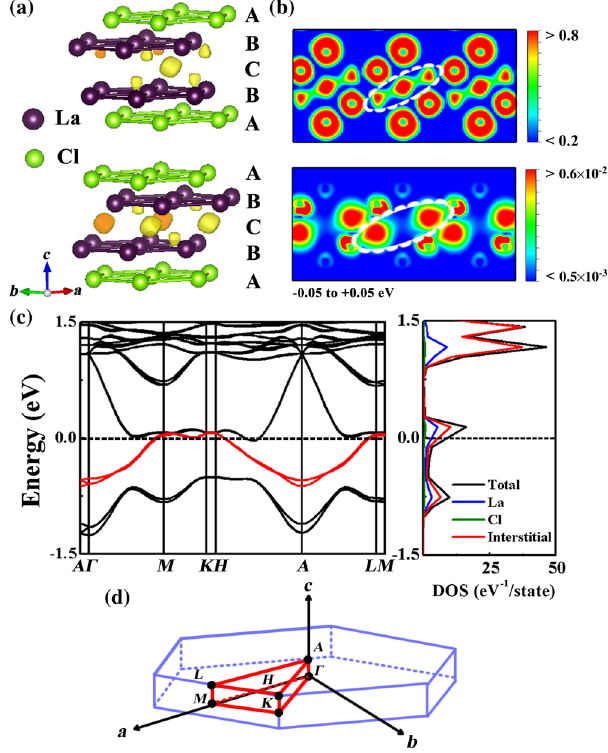
FIG. 6. Structural and electronic properties of LaCl. (a) 3D ELF of LaCl with an isosurface value of 0.7. (b) 2D ELF (top panel) on ¯1 ¯1 0 Þ the ð R plane and partial electron density for the region near E j E j < 0 . 05 eV) (bottom panel) on the ð ¯1 ¯1 0 Þ F ( R plane. (c) Band structure and electron density of state of LaCl. The dashed line indicates the Fermi energy ( E F ). (d) The high-symmetry lines (red) are in the first Brillouin